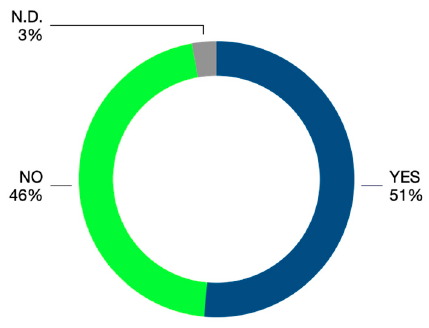
Figure 1. Judgment Figure 1. Judgment outcomes.